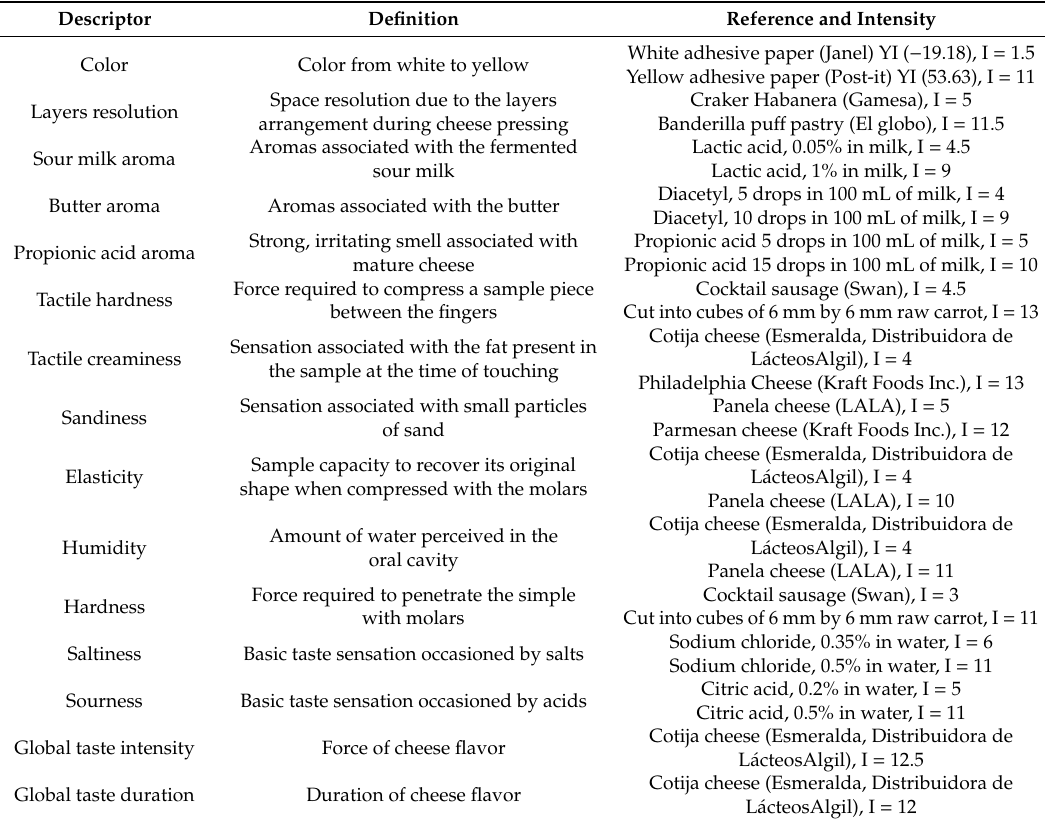
Table 1. Sensory descriptors, definitions and references for the evaluation of Poro